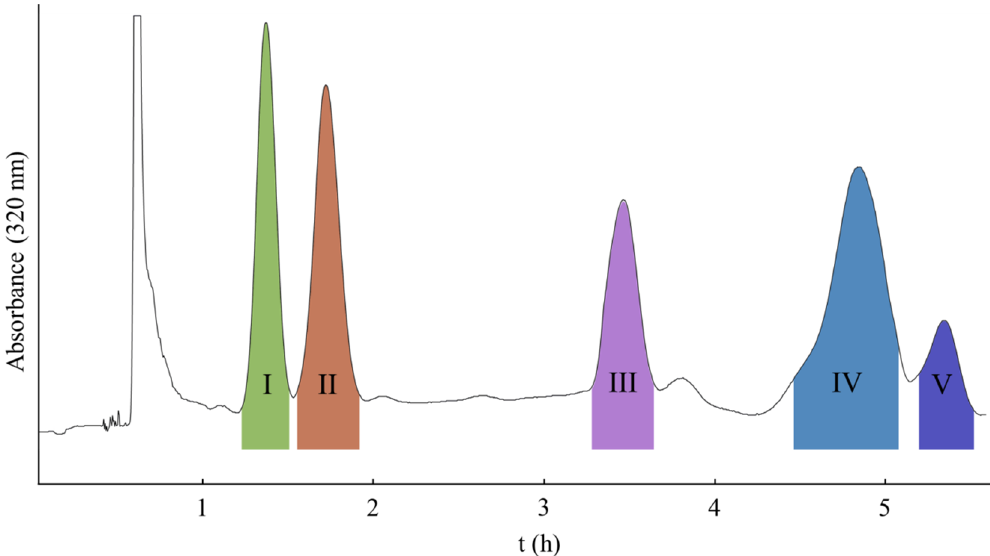
Figure 3. The linear gradient CCC procedure on the separation of coumarins from the roots of T. asiatica . Stationary phase: upper phase of n ‐ hexane/ethyl acetate/methanol/water (5:5:1:9, v / v ); mobile phase: lower phase of n ‐ hexane/ethyl acetate/methanol/water (5:5:1:9, v / v ) as mobile A and lower phase of n ‐ hexane/ethyl acetate/methanol/water (5:5:4.5:5.5, v / v ) as mobile B; linear elution condition: 0–157.5 min, 0–100% B, and 157.5–360 min, 100% B; flowrate: 5.0 mL/min; and detection wavelength: 320 nm.